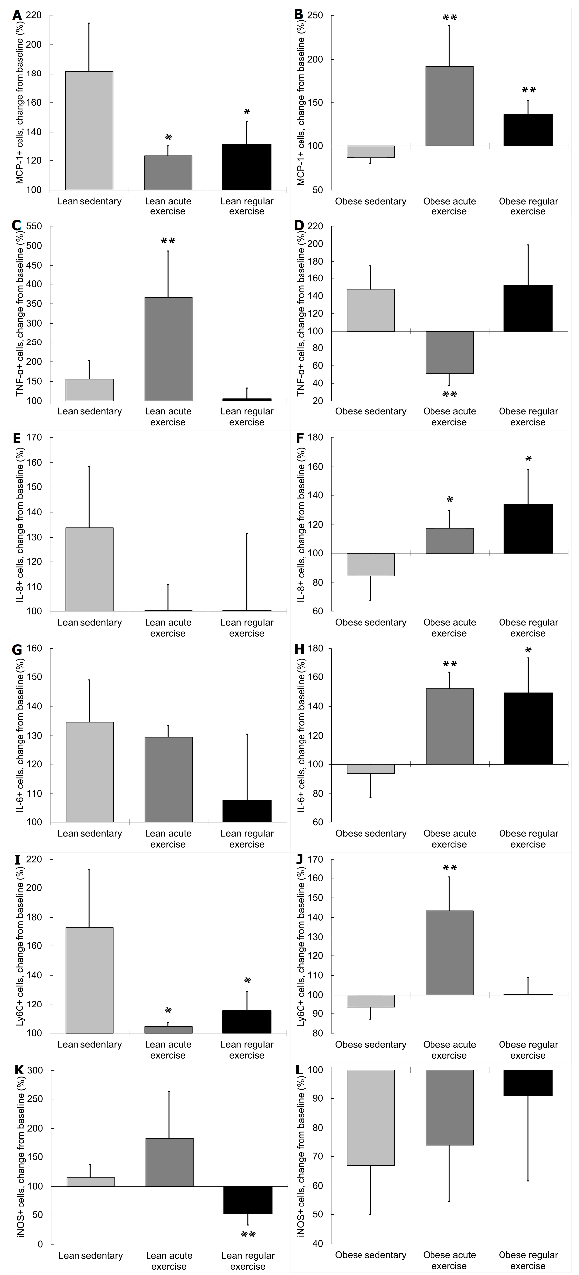
Figure 4. Effect of exercise on β 2 adrenergic regulation of monocytes expressing pro-inflammatory cytokines (MCP-1, TNF- α , IL-8, IL-6) and pro-inflammatory phenotype (Ly6C, iNOS) in lean (sedentary n = 9; acute exercise n = 5; regular exercise n = 6) and obese mice (sedentary n = 8; acute exercise n = 5; regular exercise n = 6). Data are expressed as percentage change from baseline after β 2 adrenergic stimulation with terbutaline (giving “100” to the basal values in the absence of terbutaline): ( A , B ): MCP-1+ cells in lean and obese mice, respectively. ( C , D ): TNF- α + cells in lean and obese mice, respectively. ( E , F ): IL-8+ cells in lean and obese mice, respectively. ( G , H ): IL-6+ cells in lean and obese mice, respectively. ( I , J ): Ly6C+ cells in lean and obese mice, respectively. ( K , L ): iNOS+ cells in lean and obese mice, respectively. Columns show the mean ± SEM of independent assays performed in duplicate in each animal. * p < 0.05, ** p < 0.01 vs. the corresponding sedentary mice group.